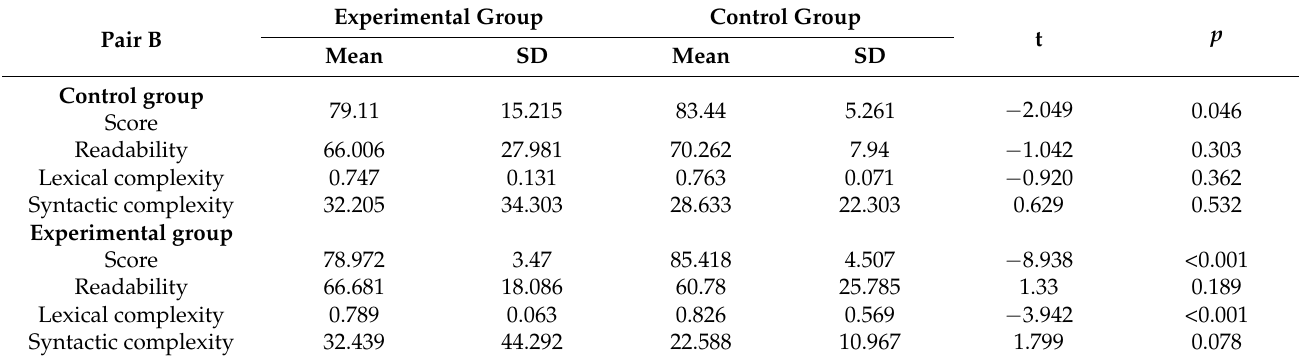
Table 2. Descriptive statistics and t -test results, pretest and posttest.